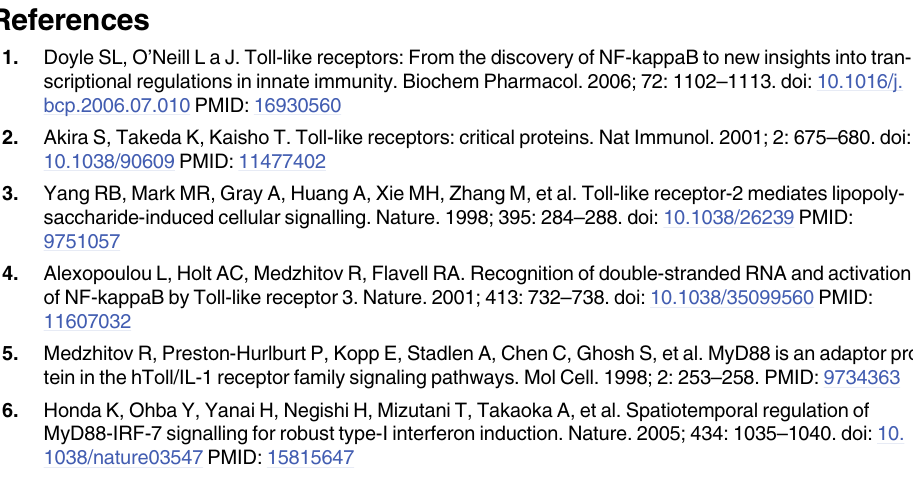
S1 Table. Nitric oxide production from chicken macrophages treated with encapsulated or free TLR ligands. S2 Table. Cytokines gene expression by chicken macrophages after treatment with encap- sulated or soluble forms of TLR ligands. S3 Table. Live body weight gains of chickens intramuscularly injected with PLGA NPs. S4 Table. Cytokines gene expression in spleen of chickens intramuscularly injected with encapsulated or soluble